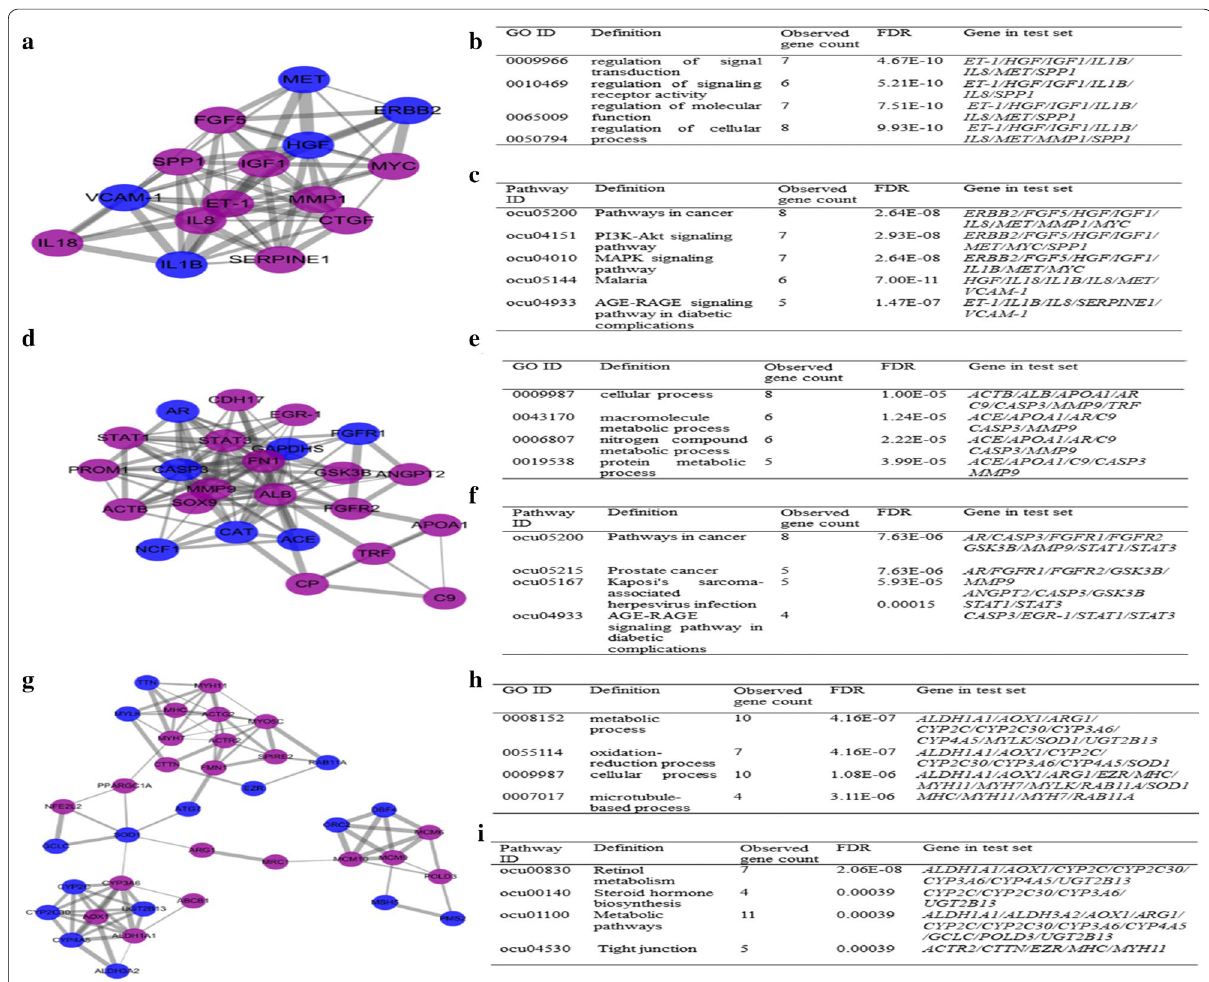
Fig. 4 Module analysis of PPI network. a module 1; b module 2; g module 3; Purple represents high relative expression and blue represents low relative expression. GO enrichment analysis of module 1, module 2, and module 3 for b , e and h respectively. The ontology mainly covered the first few important biological processes; KEGG pathway analysis of module 1, module 2, and module 3 for c , f and i